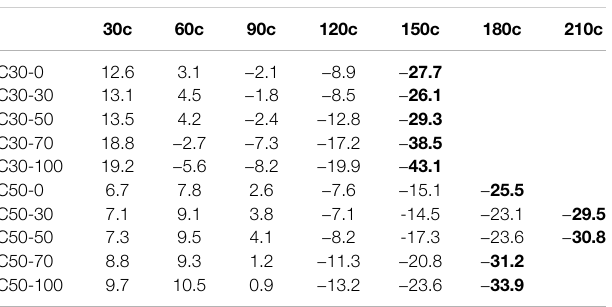
TABLE 8 | Relative ultrasonic velocity factor of concrete after sulfate wetting – drying